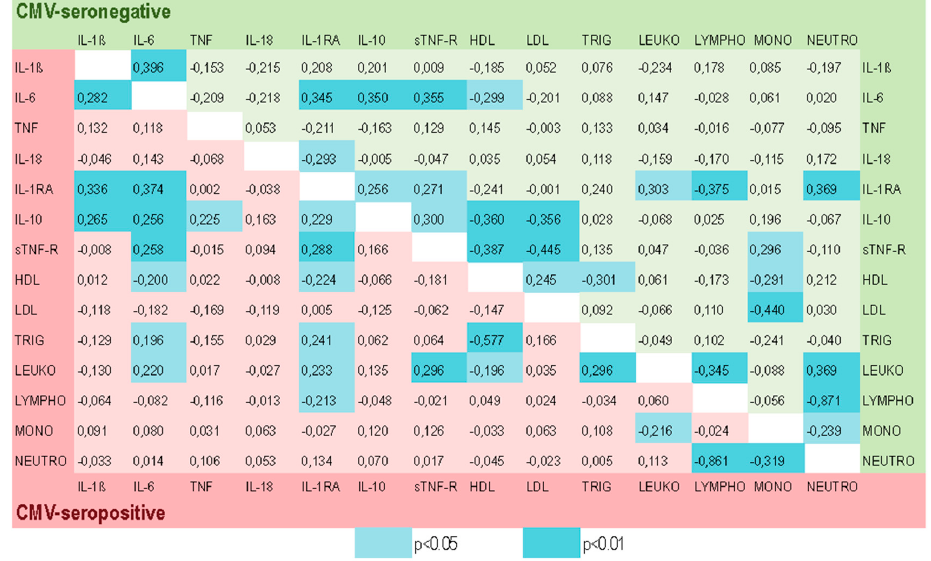
Figure 4. Correlations among different blood biomarkers and the modulatory effect of CMV-seropositivity. Correlation coefficients are presented for CMV-negative in the green field and for CMV-positive in the red field. The significant values are highlighted in light blue ( p < 0.05) and dark blue ( p < 0.01). IL-1 β : interleukin 1 beta; IL-1RA: interleukin 1 receptor antagonist; IL: interleukin; TNF: tumor necrosis factor; sTNF-R: soluble tumor necrosis factor receptor; HDL: high-density lipoprotein; LDL: low-density lipoprotein; LYMPHO: lymphocytes; LEUKO: leukocytes; MONO: monocytes; NEUTRO: